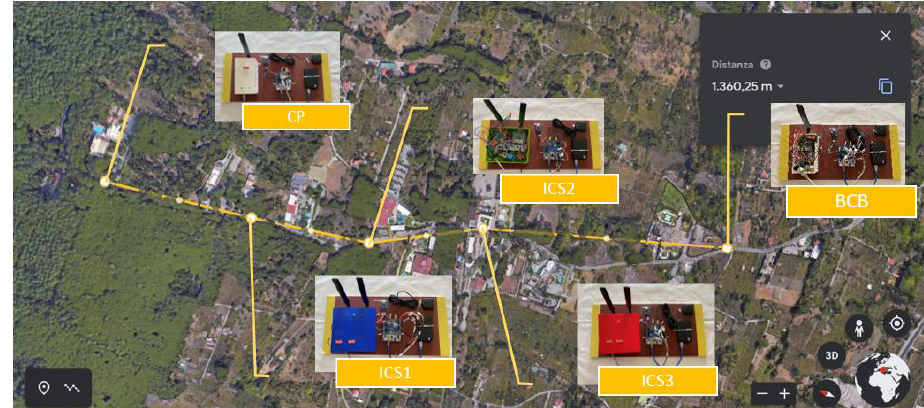
Figure 8. Position of devices for tests in rural